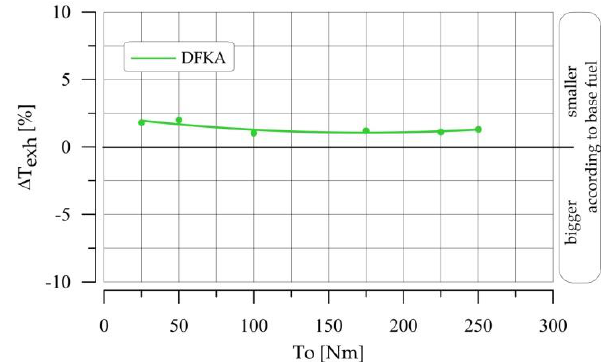
The percentage differences in the values of the hourly fuel consumption (FC) in the individual points of the F test (at the same engine speed and load of the engine powered by both fuels) are the same as the percentage differences in the values of the overall engine efficiency (η o